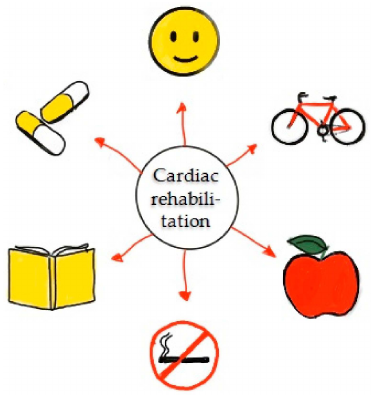
Figure 2. Components of a cardiac rehabilitation program. Such a program includes interventions on behavior, exercise, nutrition, smoking cessation, education, and medicines